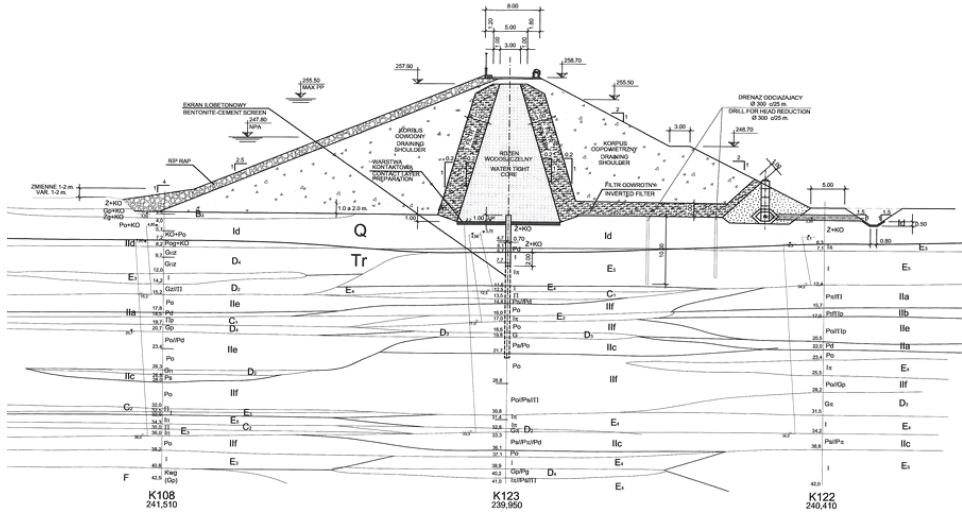
Fig. 3. Cross-section through the front dam with bedrock geology according to [1]